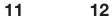
TABLE 1 | Correlations, Means, standard deviations, and Cronbach’s alpha between study variables separately for each cultural group. Measure α tot α US α IT α